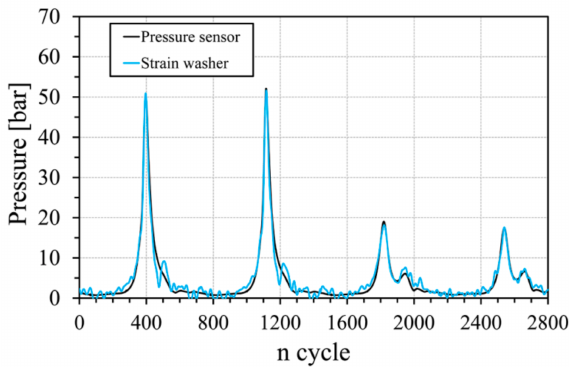
Figure 18. In-cylinder pressure of four consecutive cycles with misfiring events at 4000 rpm and full load measured by the pressure sensor and derived from the strain washer signal.